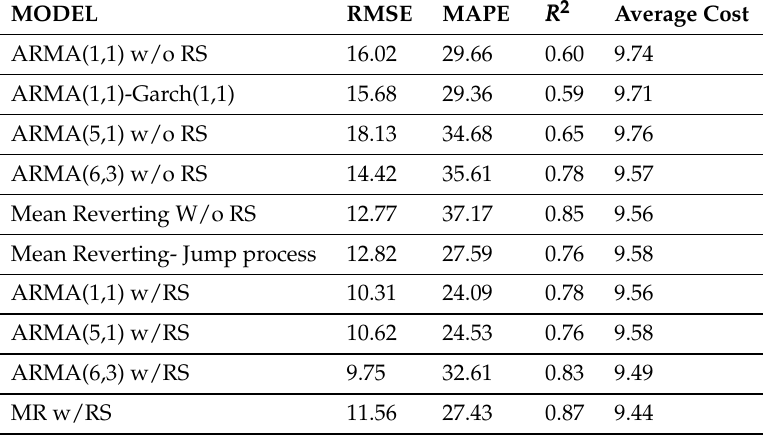
Table 6. Out-of-sample error measures and electricity purchase